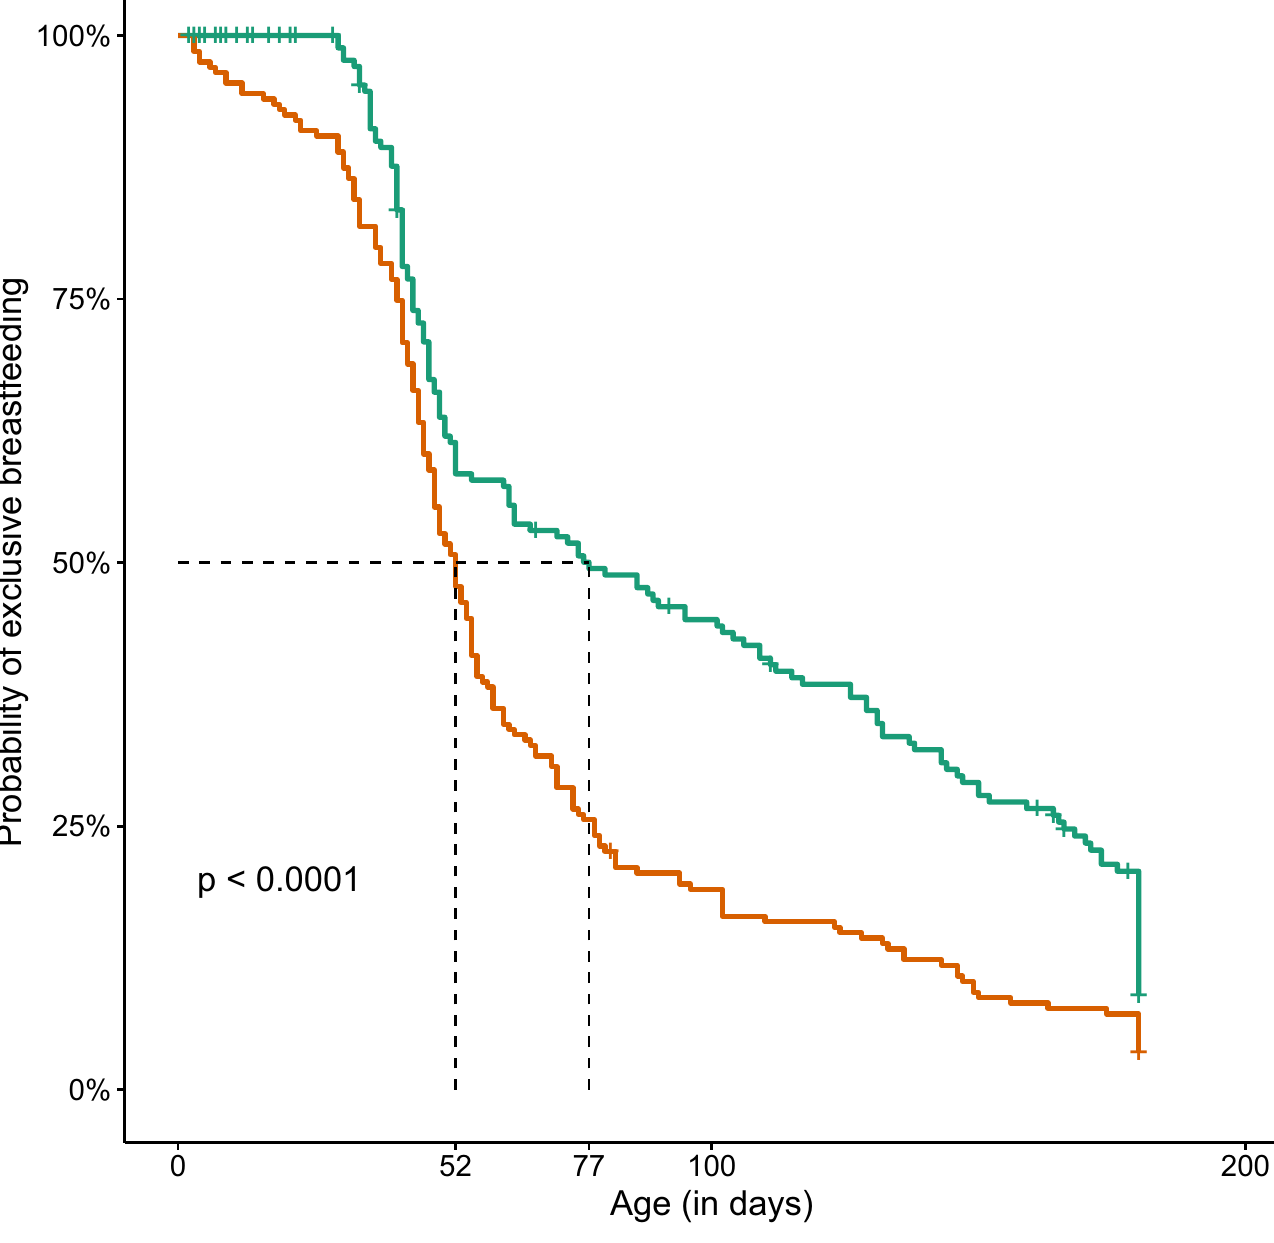
Fig 3. Kaplan-Meier of exclusive breastfeeding according to the feeding practice at hospital discharge of the 393 newborns in risk groups 1 and 2, Brazil,